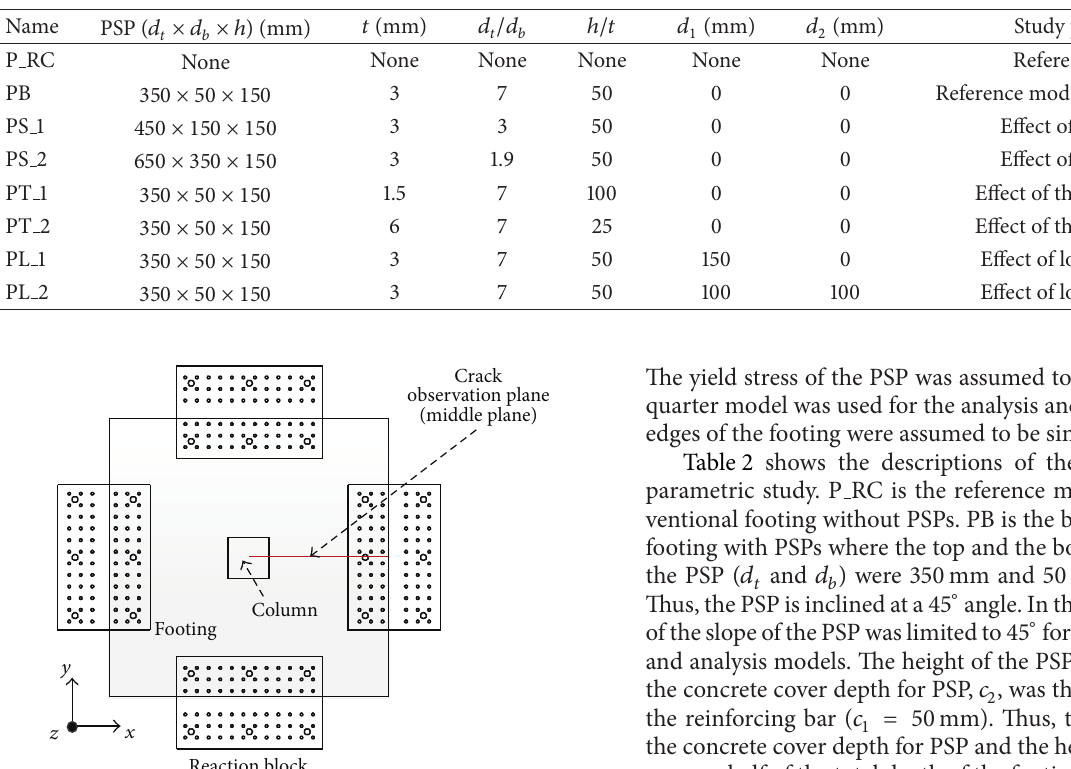
Table 2: Models for parametric study.